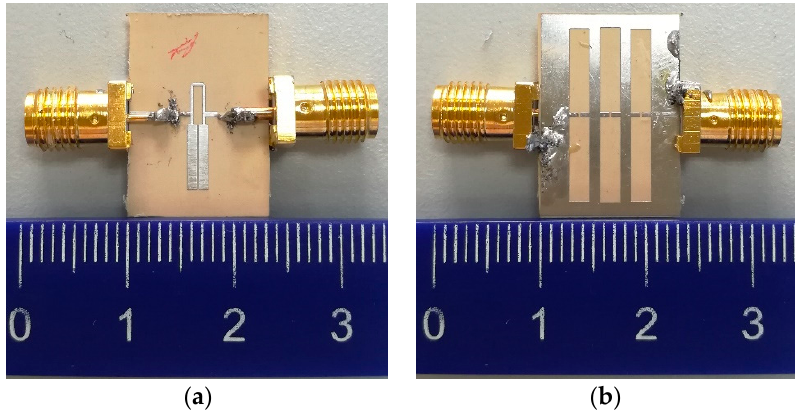
Figure 8. The fabricated microstrip LPF based on SIR and DGS: ( a ) top layer and ( b ) bottom layer.